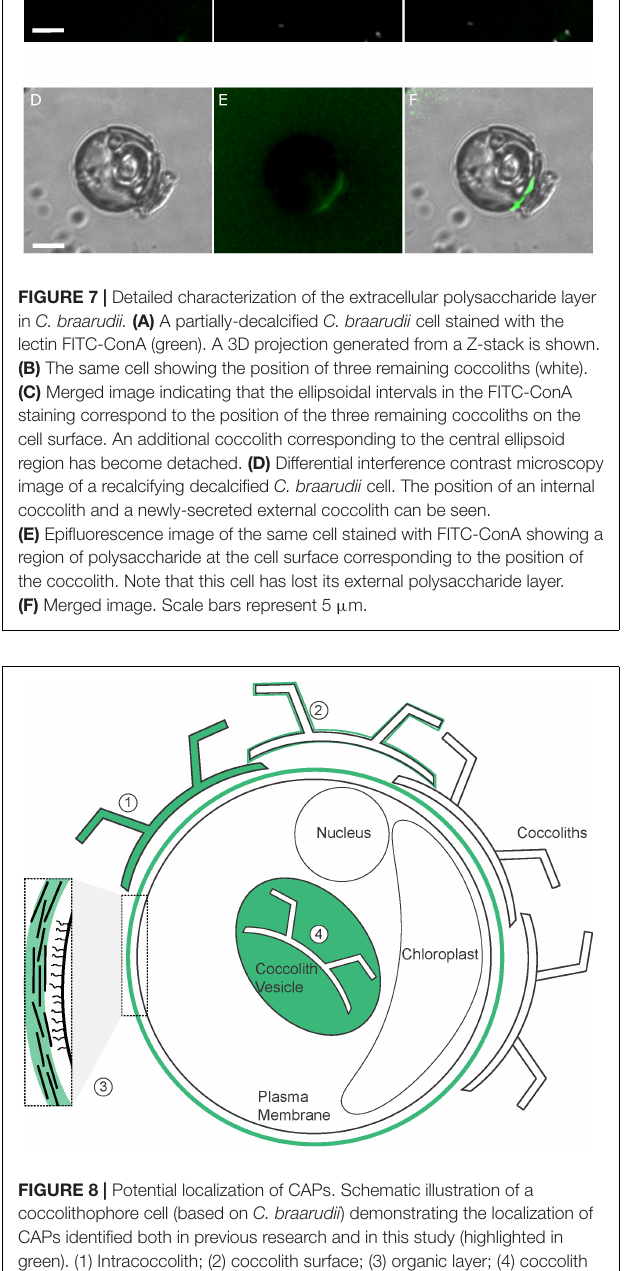
( Figure 8 and Supplementary Table 1 ). These are